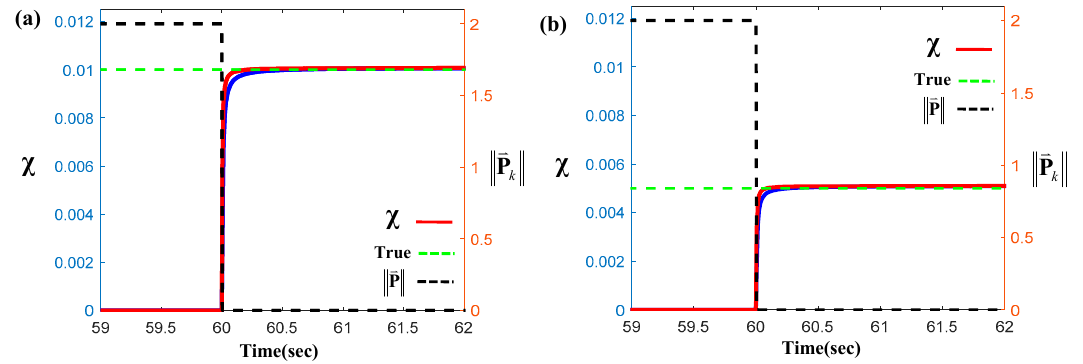
µ ] T (( a ) result for µ f 2 1